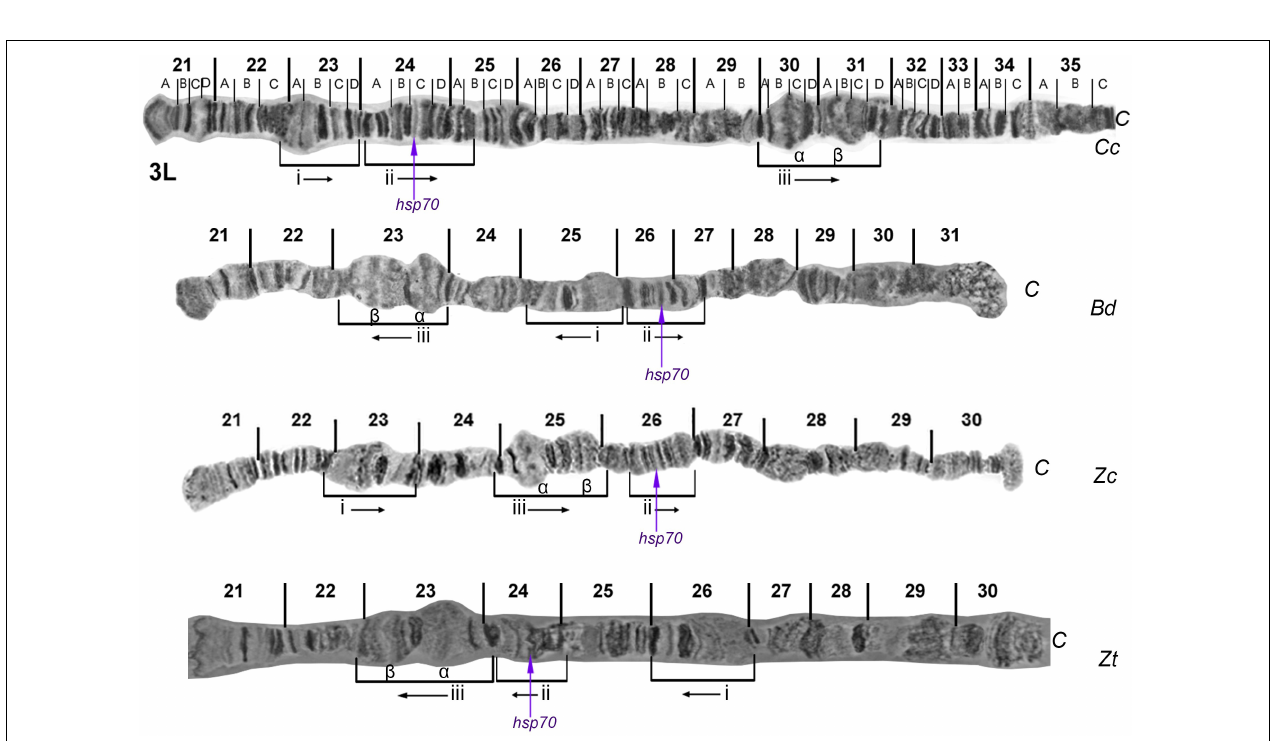
FIGURE 5 | Banding pattern comparison between 3L reference maps of Zeugodacus tau (Zt) with Ceratitis capitata (Cc), Bactrocera dorsalis (Bd), and Zeugodacus cucurbitae (Zc). Characteristic sections, their relative orientation and hybridization site of hsp70 gene are indicated. 3L of Cc and Zc modified from Figure 7 of: Zacharopoulou et al. (2011b), and 3L of Bd modified from Figure 6 of: Zacharopoulou et al. (2017).